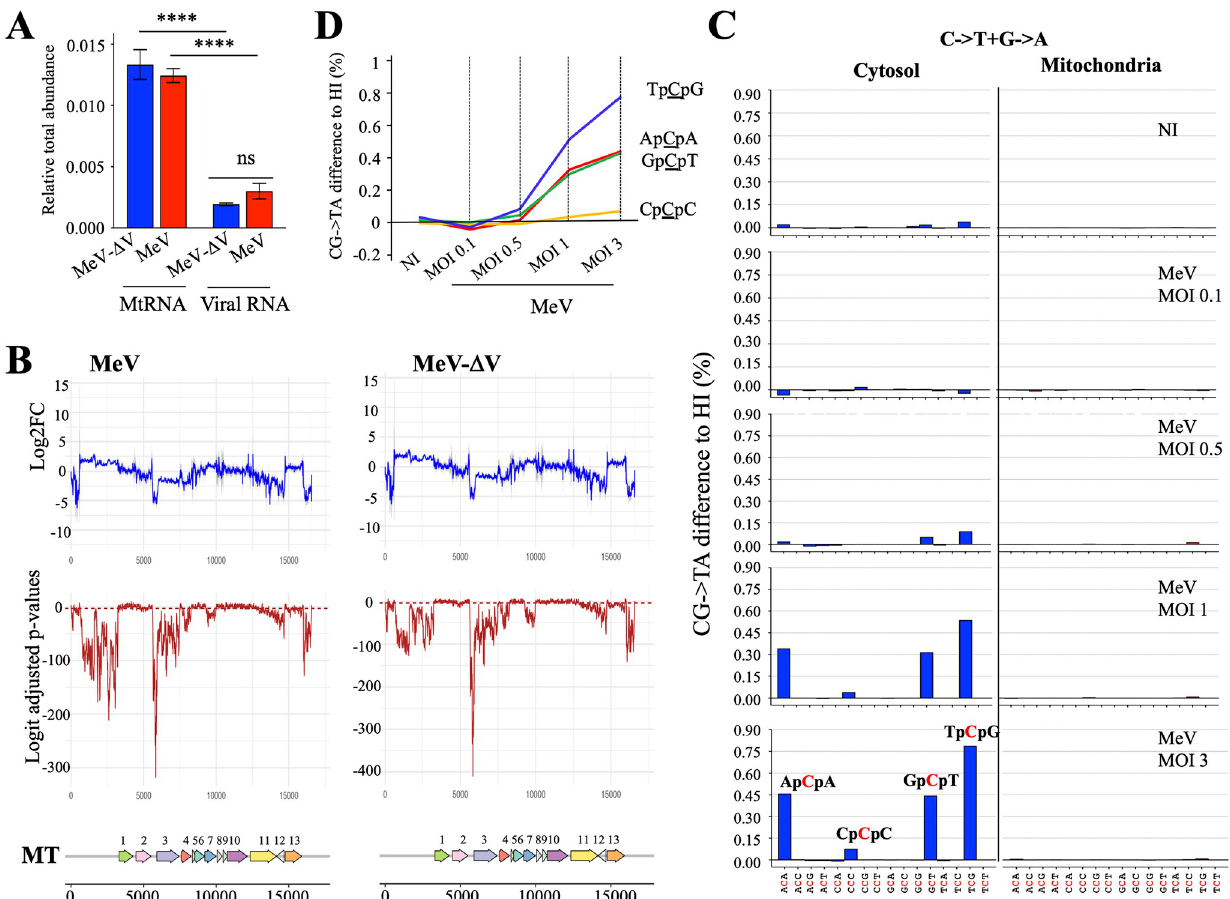
Fig 6. MtRNA binding to RIG-I, DNA mtDNA editing and context analysis. A) STrEP-tagged RIG-I obtained from total MeV or MeV- Δ V infected cell lysates were purified by affinity chromatography. Mitochondrial or viral RNA molecules biding to RIG-I was detected Next Generation Sequencing (NGS) analysis and was normalized to non-specific binding to the beads from STrEP-tagged-Cherry cells. Mean values and s.e.m. were calculated for three independent experiments in duplicate (n = 6), unpaired two-side Student’s t-test ��� , p < 0.005, ns: not statistically significant. B) Upon MeV and MeV- Δ V infections, the raw counts obtained for each position to calculate mtRNA binding efficiency and specificity between RIG-I and m-Cherry were performed using the DESeq2 package of R and were aligned to the mitochondrial genome. The grey area corresponds to the 95% confidence interval of the log2FC. The logit of the p-values was adjusted by the Benjamini-Hochberg method. The dashed line in red corresponds to the 5% threshold value. Bottom: Annotation of the mitochondrial genome. 1: MT-ND1; 2: MT-NT2; 3: MT-CO1; 4: MT-CO2; 5: MT-ATP8; 6: MT-ATP6; 7: MT-CO3; 8: MT-ND3; 9: MT-ND4L; 10: MT-ND4; 11: MT-ND5; 12: MT-ND6; 13: MT-CYB. C) Pattern of C- > T and G- > A mutations analyzed in mtDNA in the cytosol and mitochondria. Difference of mutation proportion between MeV at 0.1, 0.5, 1 and 3 MOI and NI sample. the different trinucleotides associated with the context are indicated at the bottom of the figure. The deaminated C is identified in red. D) C- > T and G- > A mutations occurring in specific contexts analyzed in cytosolic mtDNA.